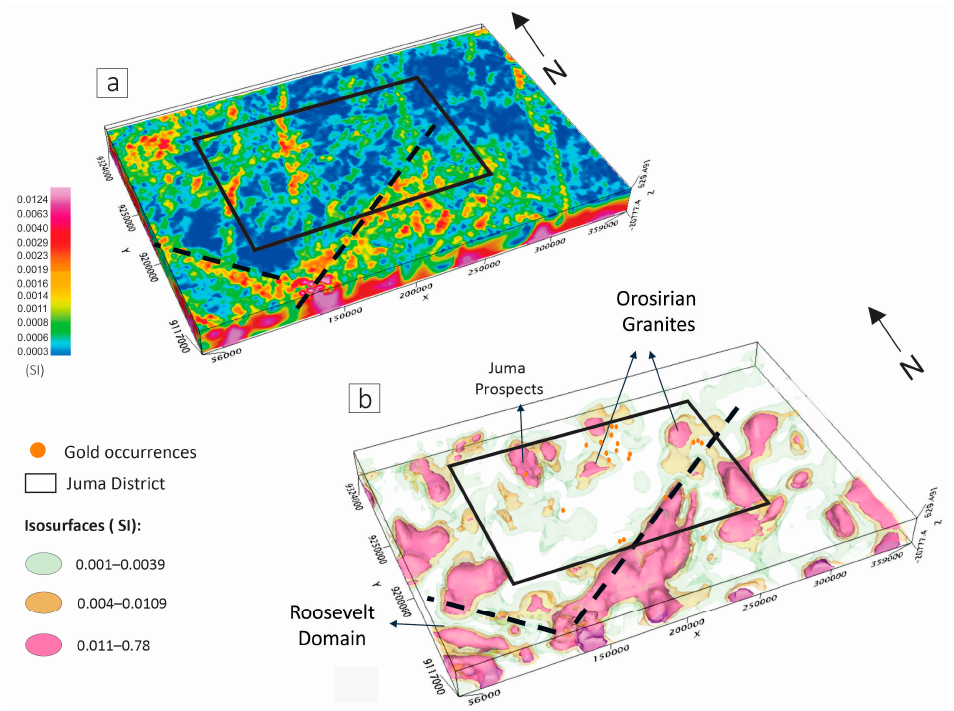
Figure 10. The regional MVI models show: ( a ) the continuity of the magnetic susceptibility in 3D beyond the Juma District limits; ( b ) the most relevant regional isosurfaces and the gold occurrences.